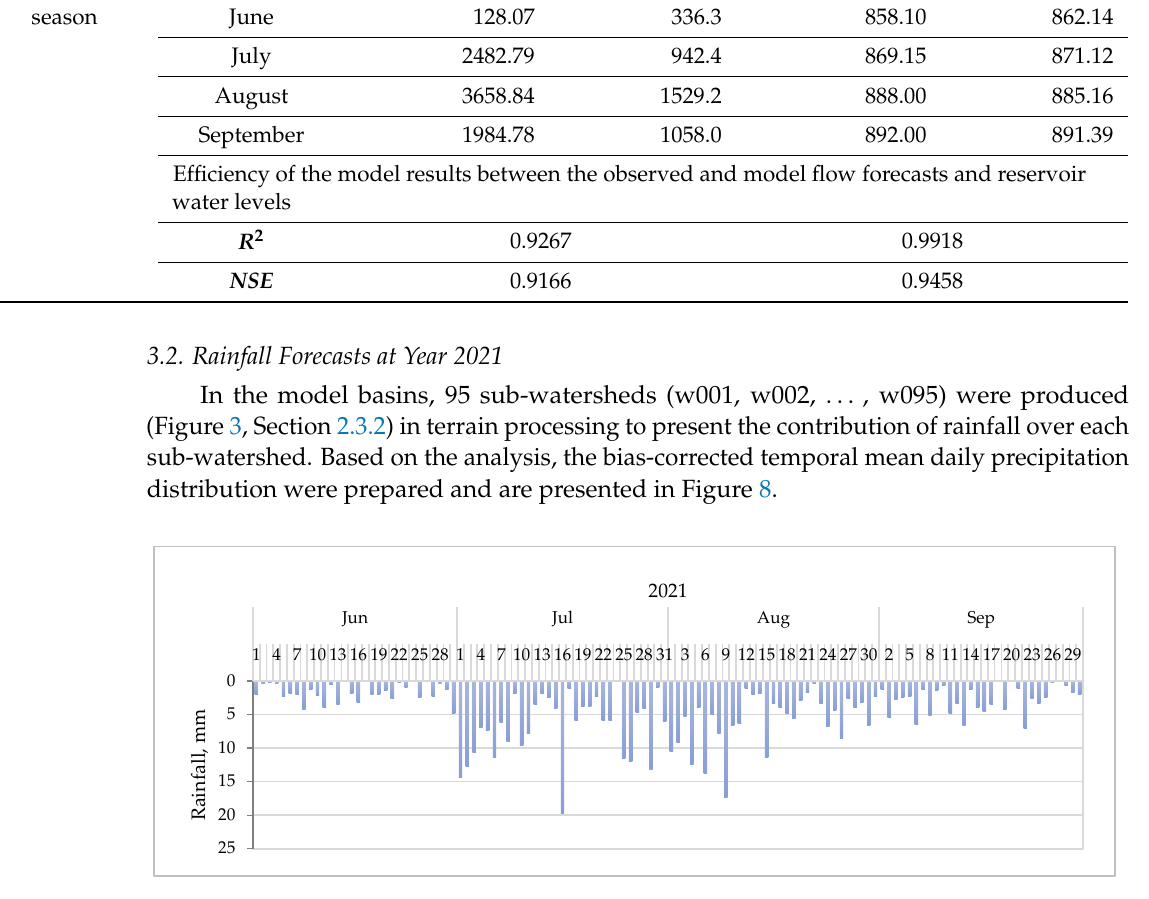
( a ) ( b ) ( c ) ( d ) Figure 9. Spatial precipitation distribution for the 2021 flood season (June to September). ( a ) presents the precipitation distribution for the month of June; ( b ) presents the precipitation distribution for July; ( c ) presents the precipitation distribution for August; ( d ) presents the precipitation distribution for September. Moreover, the mean accumulated monthly precipitation (Figure 10) showed increas- ing trends from June (57.5 mm) to July (201.2 mm) and started decreasing after July to August (172.5 mm) and September (90.0 mm). Moreover, the historical mean monthly rainfall is presented in comparison with the 2021 flood season rainfall forecasts (Figure 10). In essence, the rainfall forecasts showed agreement with the underestimated values for June and September and were overestimated for July and August.